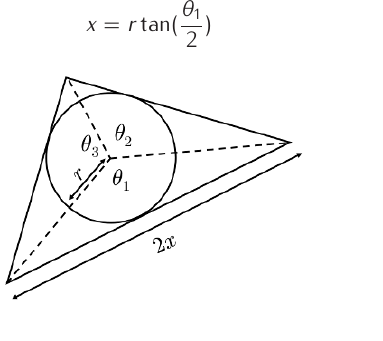
Figure 13. A 3-sided circumscribed